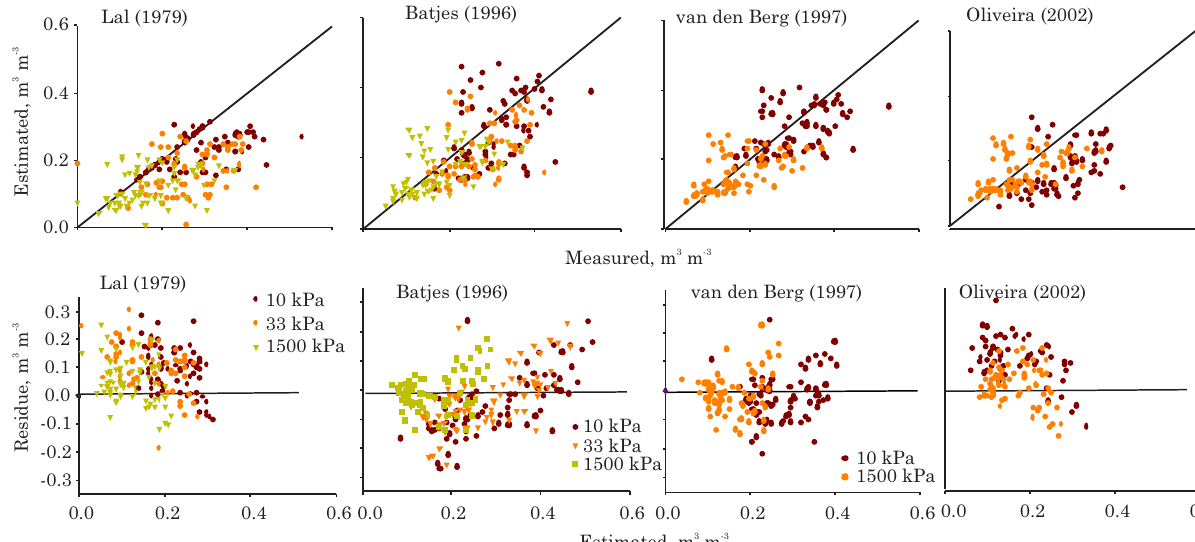
x – : mean of the estimated values (m 3 m -3 ); RMSE: root mean square error; ME: mean error; R 2 : coefficient determination; CI : Confidence Index proposed by Camargo & Sentelhas (1987); no: no PTF for that potential.